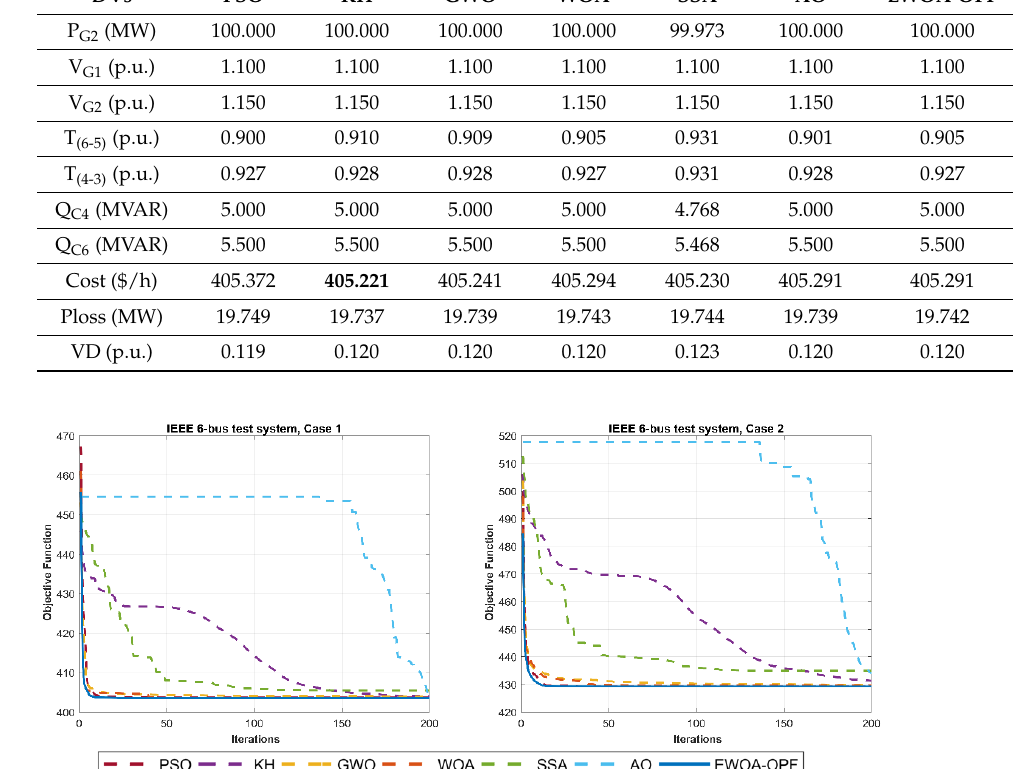
Table 3. Results of OPF for IEEE 6-bus test system on Case 2.